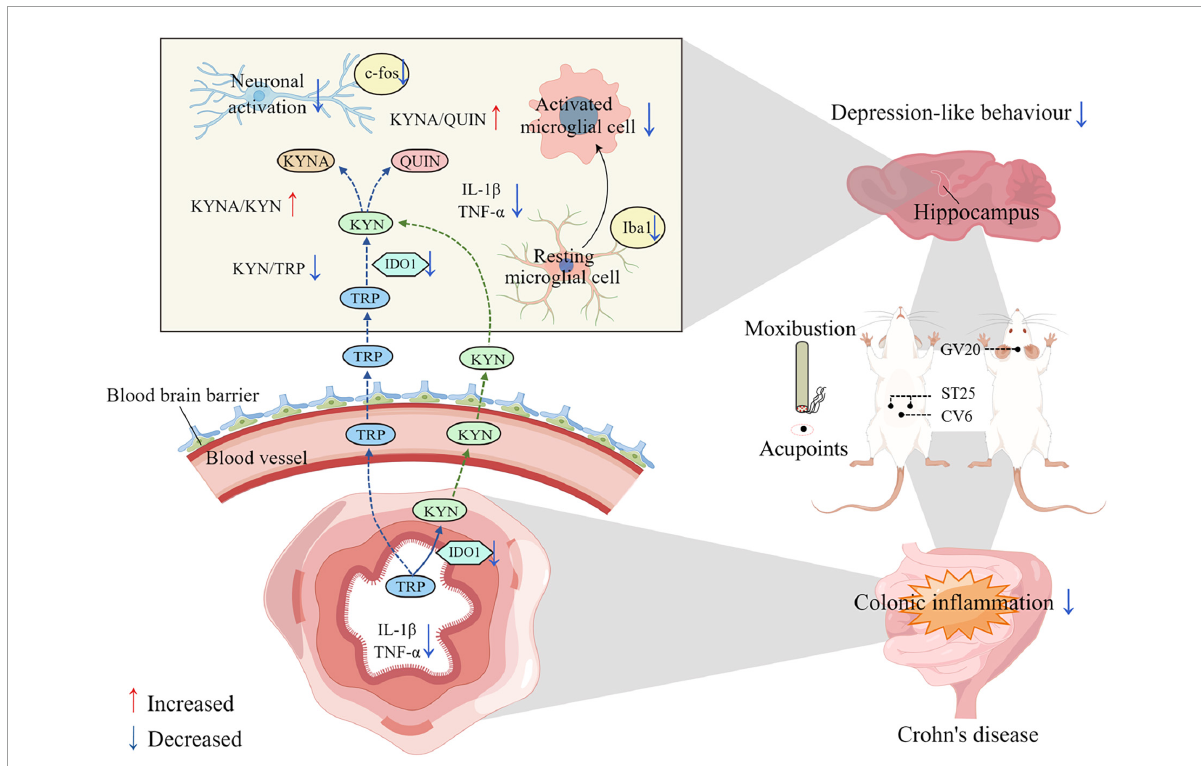
FIGURE10 Schematic illustration of this research: the potential mechanism by which moxibustion inhibits gut-brain axis kynurenine pathway (KP) metabolism in the treatment of 2,4,6-trinitrobenzenesulfonic acid (TNBS)-induced depressive behavior in rats with Crohn’s disease (CD). The mechanism of action of moxibustion at ST25, CV6, and GV20 to improve depression-like behavior and intestinal inflammation in rats with CD may be due to the reduction of intestinal inflammatory cytokines, such as IL-1 β and TNF- α , after moxibustion treatment. These inflammatory factors further reduced the activation of intestinal IDO1 and inhibited the excessive degradation of TRP to KYN in the intestine. KYN crosses the blood-brain barrier through the gut-brain axis and enters the brain, where it is further metabolized to KYNA and QUIN. In contrast, the increased ratio of KYNA/KYN and KYNA/QUIN, reduced microglia activation and neuronal activity in hippocampus after moxibustion intervention may be one of the mechanisms by which moxibustion alleviates depression-like behavior in rats with